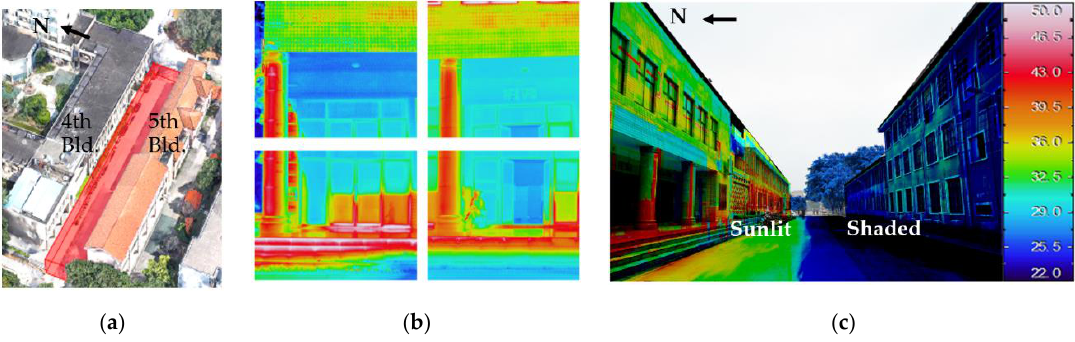
Figure 3. 3D models and thermal images around the teaching buildings. ( a ) 3D model; ( b ) thermal images taken at 14:00, 24 December 2018; ( c ) 3D thermography jointed from 178 pieces of 2D thermal images.